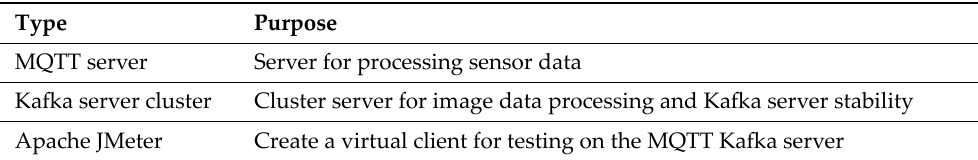
Table 3. System components for evaluation.